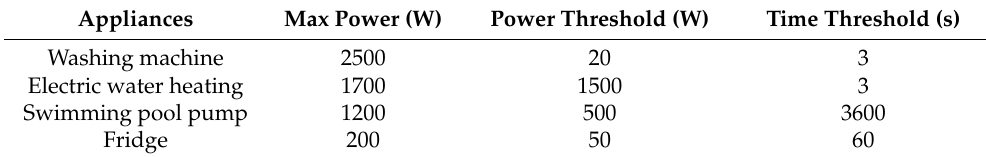
Table 2. Parameters used to generate appliance status.